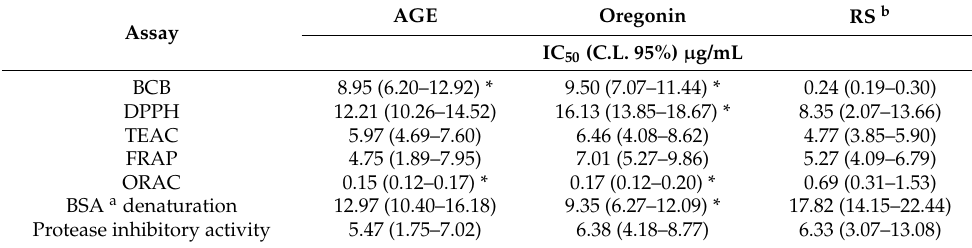
Figure 3 . Antioxidant and anti-inflammatory activity of A. glutinosa stem bark extract (AGE): DPPH ( a ), FRAP ( b ), TEAC ( c ), ORAC ( d ), Bovine serum albumin (BSA) denaturation, ( e ) Protease inhibitory activity, ( f ) Panels ( a – e ) show the linear correlation coefficient (R 2 ), which highlights the concentration-dependent behavior of AGE. Table 2. Determination of antioxidant and anti-inflammatory activity of A. glutinosa stem bark extract (AGE) by several in vitro assays based on different environments and reaction mechanisms. Results, which were expressed as half-maximal inhibitory concentration (IC 50 , µ g/mL) with confidence limits at 95% (C.L.), are the mean of three independent experiments in triplicate ( n = 3) and are compared to the main bioactive compound oregonin and the reference standard